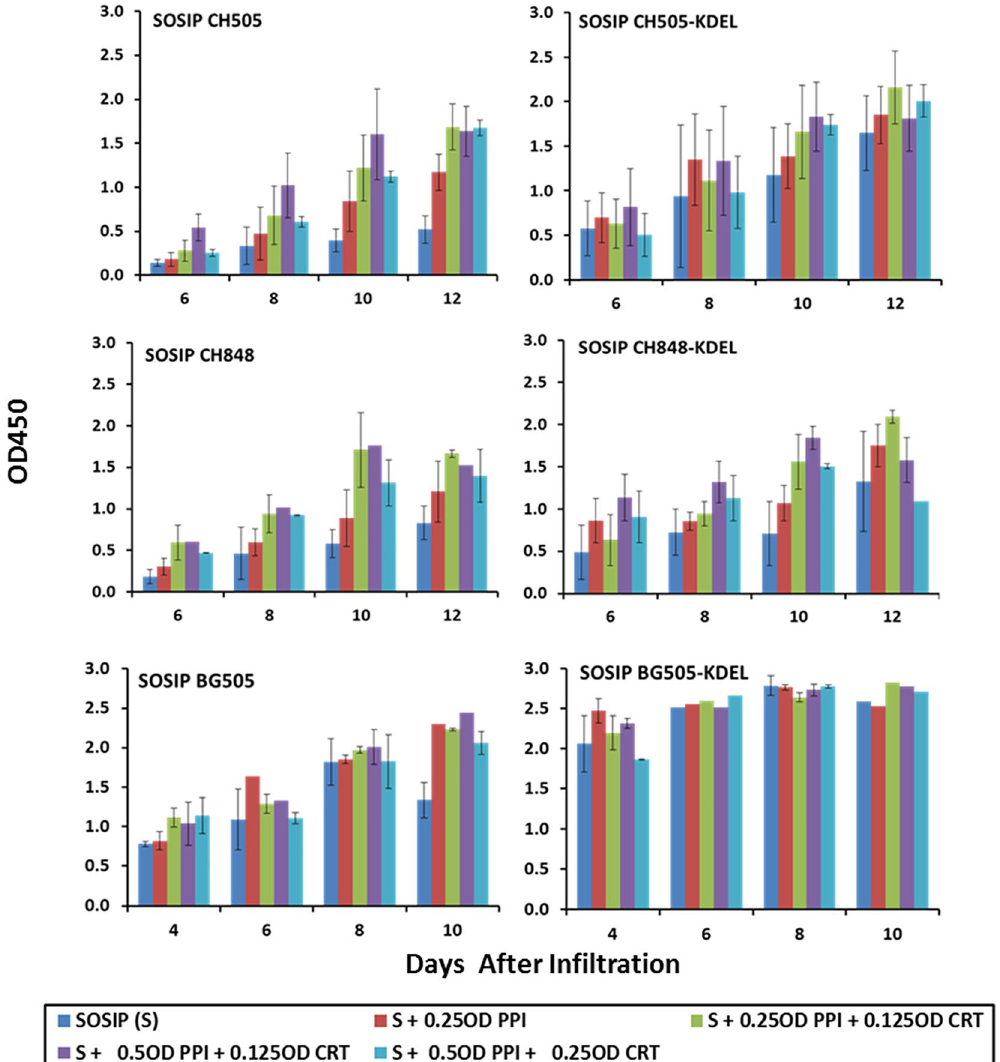
Figure 6. Chaperone mediated enhancement of KDEL forms of SOSIPs. Expression levels at different days after infiltration of non-KDEL and KDEL forms of CH505 ( A ), CH848 ( B ) and BG505 ( C ) were compared in the presence of different ratios of CRT and PPI chaperones. Based on ELISA titrations using purified BG505 SOSIP, the level of expression of plant-derived SOSIP Envelopes in several infiltrations was 30–60 mg/kg for BG505 and 10–40 mg/kg for the CH505 and CH848. It should be noted that 1/12 dilutions of extract were used for the CH505 and CH848 SOSIPS and BG505-KDELresults reached saturation by ~ day 6 at 1/24